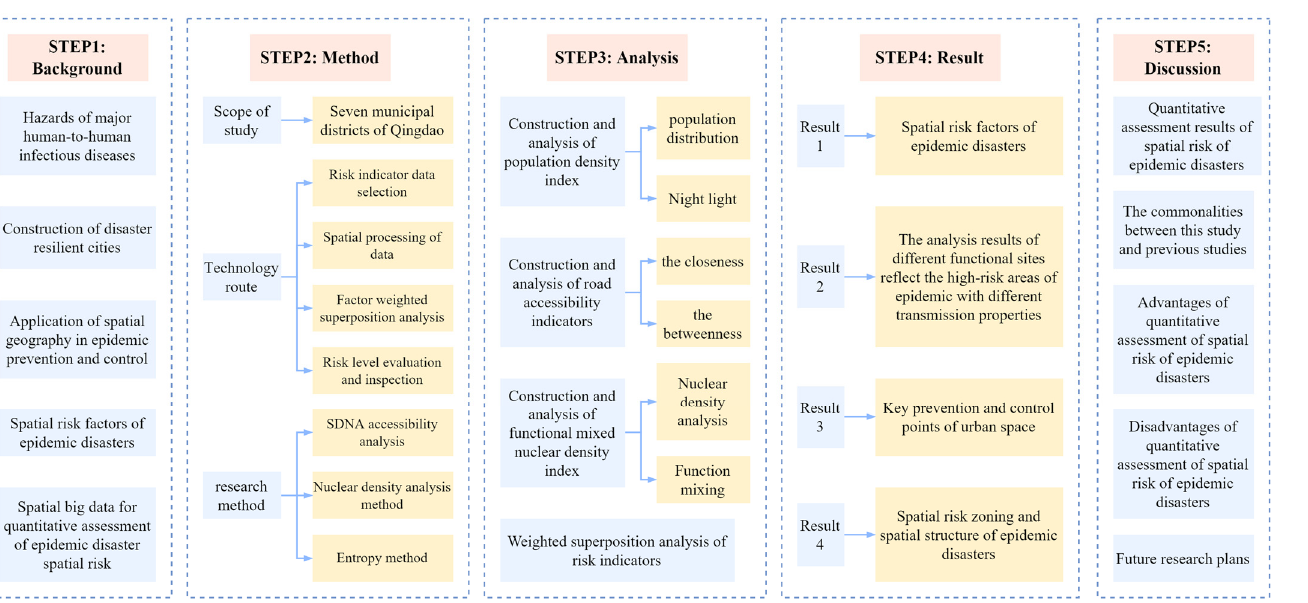
Figure 1. Article